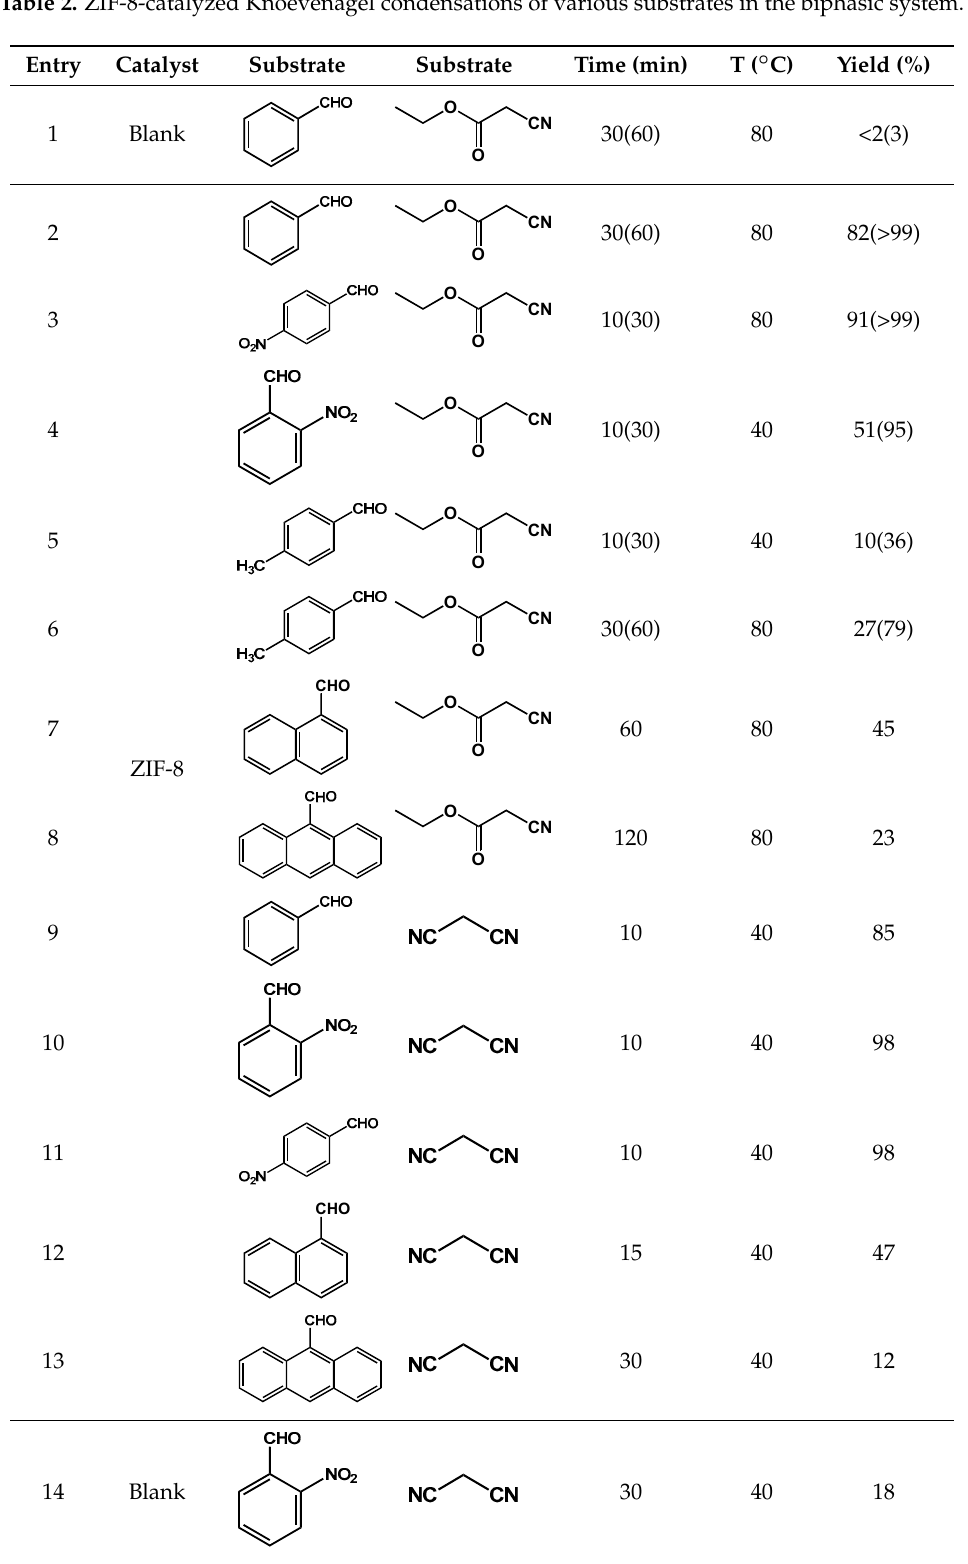
Reaction conditions: 3.5 mmol aldehyde, 4 mmol ethyl cyanoacetate or malononitrile, 25 mg ZIF-8 in